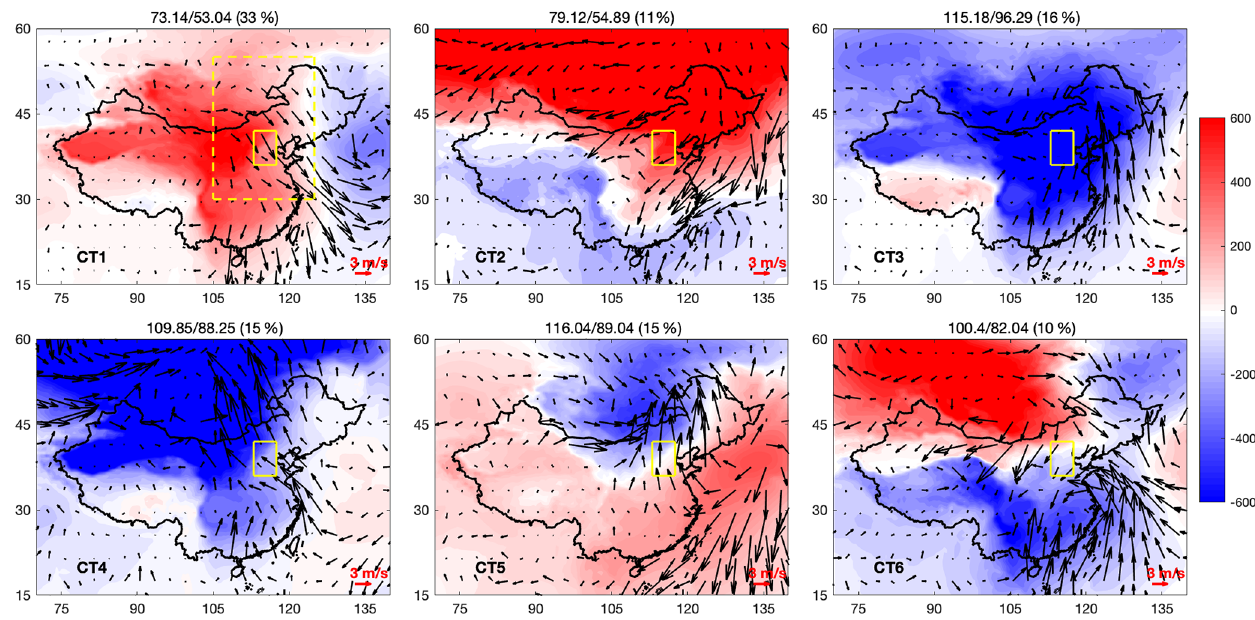
Figure 3. The distribution of sea level pressure (unit: Pa) and 10m wind field (unit: ms − 1 ) anomalies in each circulation type. The anomaly values are with respect to the 1980–2010 mean. The regional mean wind speed anomaly of each circulation type is summarized in Table